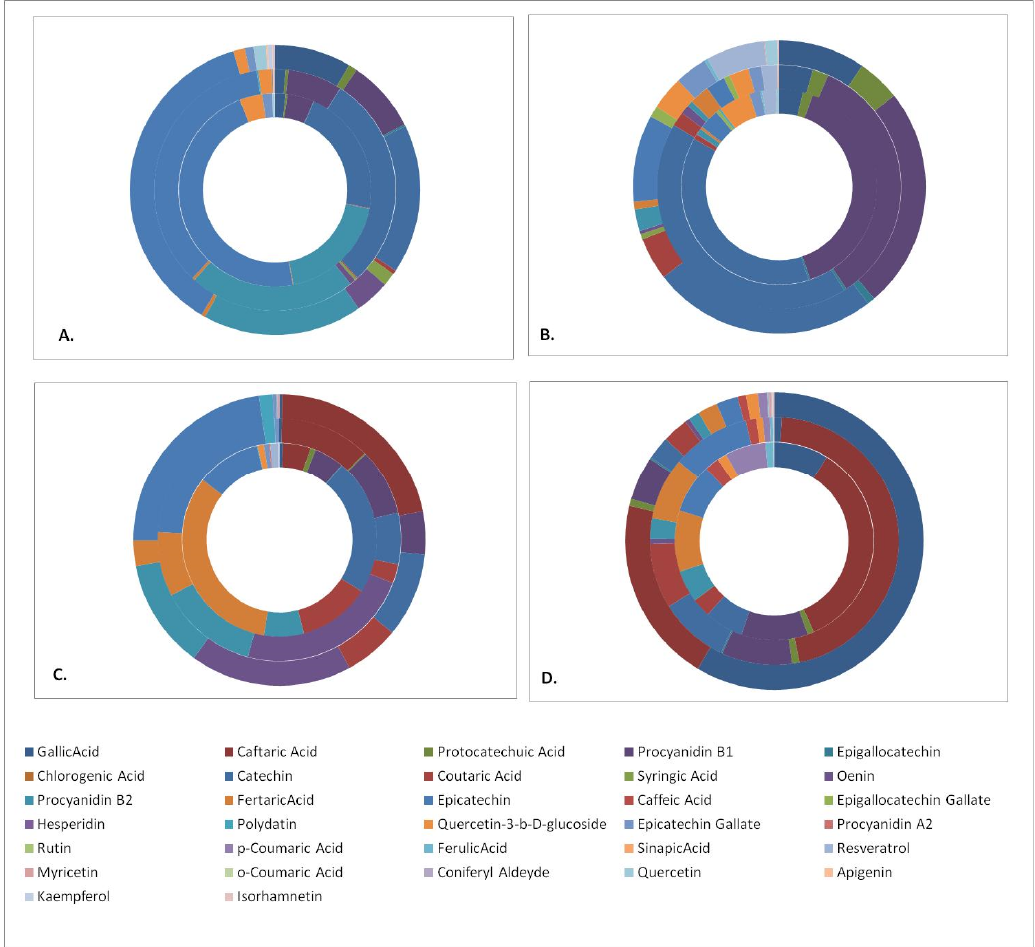
Figure 1. Phenolic compound content of samples studied. ( A ) pomace, ( B ) stems, ( C ) grapes and ( D ) wines. Varieties: inner disk, Monemvassia; middle disk, Mandilaria; outer disk, Aidani mavro.